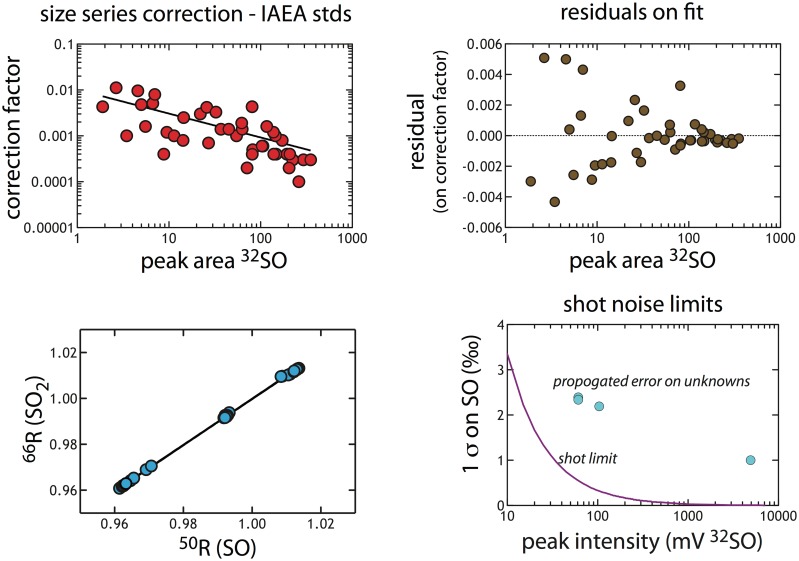
The size series correction calculated from IAEA standards (n = 44). (A) Plots the correction (value from |50Rpredicted−50Rmeasured50Rpredicted| against peak-integrated area). (A) Shows the calculated residual around that fit, demonstrating a symmetric distribution that scales with peak area. This is an illustration of the goodness of the fit. (C) The regression used to convert SO data to an SO2 scale. (D) The calculated shot noise for SO as a function of signal intensity (peak height in mV). This precision limit is below that which we propagate through the correction, and is provided for reference here.